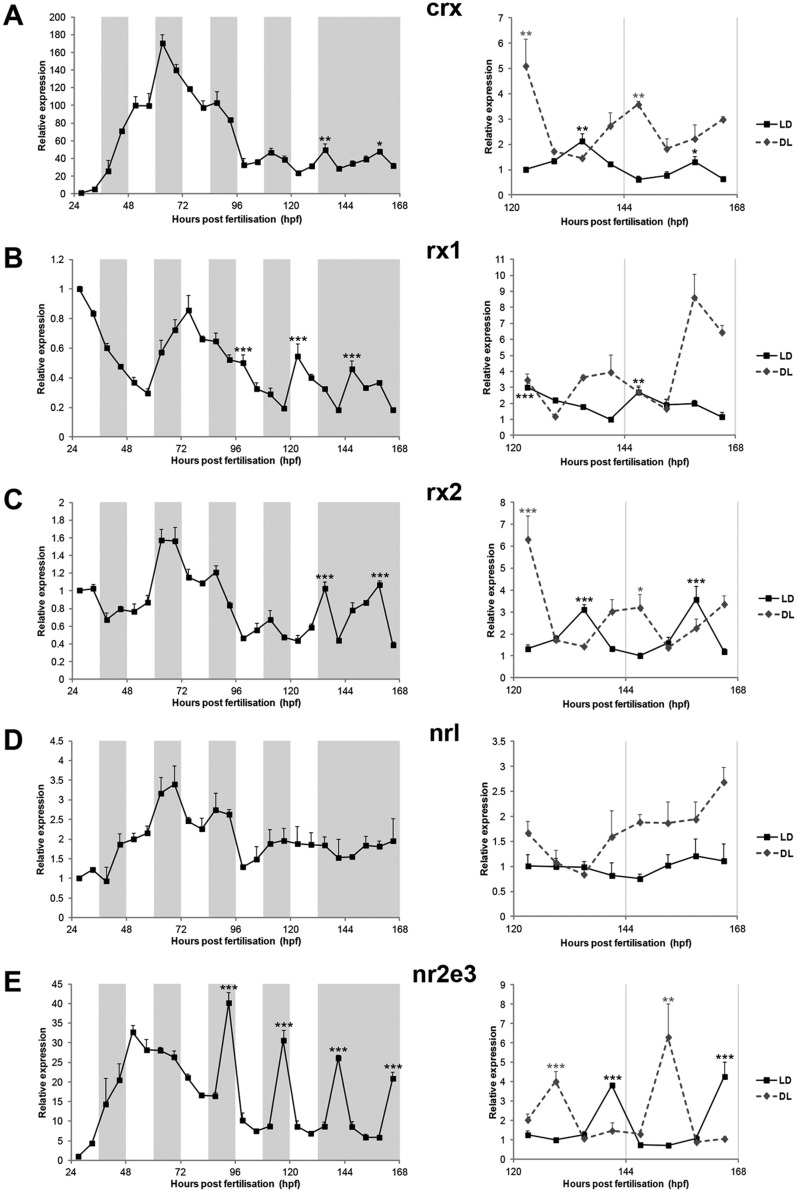
Additional retinal transcription factors are rhythmically expressed during zebrafish development. (A-E) qPCR analysis of crx (A), rx1 (B), rx2 (C), nrl (D) and nr2e3 (E) expression during zebrafish development. Expression analysis was performed on larvae raised on an LD cycle until 6 dpf and then transferred to DD on day 7 (left) or on 6-7 dpf larvae raised either on an LD or a DL cycle (right) (n=3-5). White and grey backgrounds represent light and dark phases, respectively. Statistically significant differences between the expression peak and trough on each day (Fisher's LSD test) are indicated: *P<0.05, **P<0.01, ***P<0.001. Error bars indicate s.e.m.